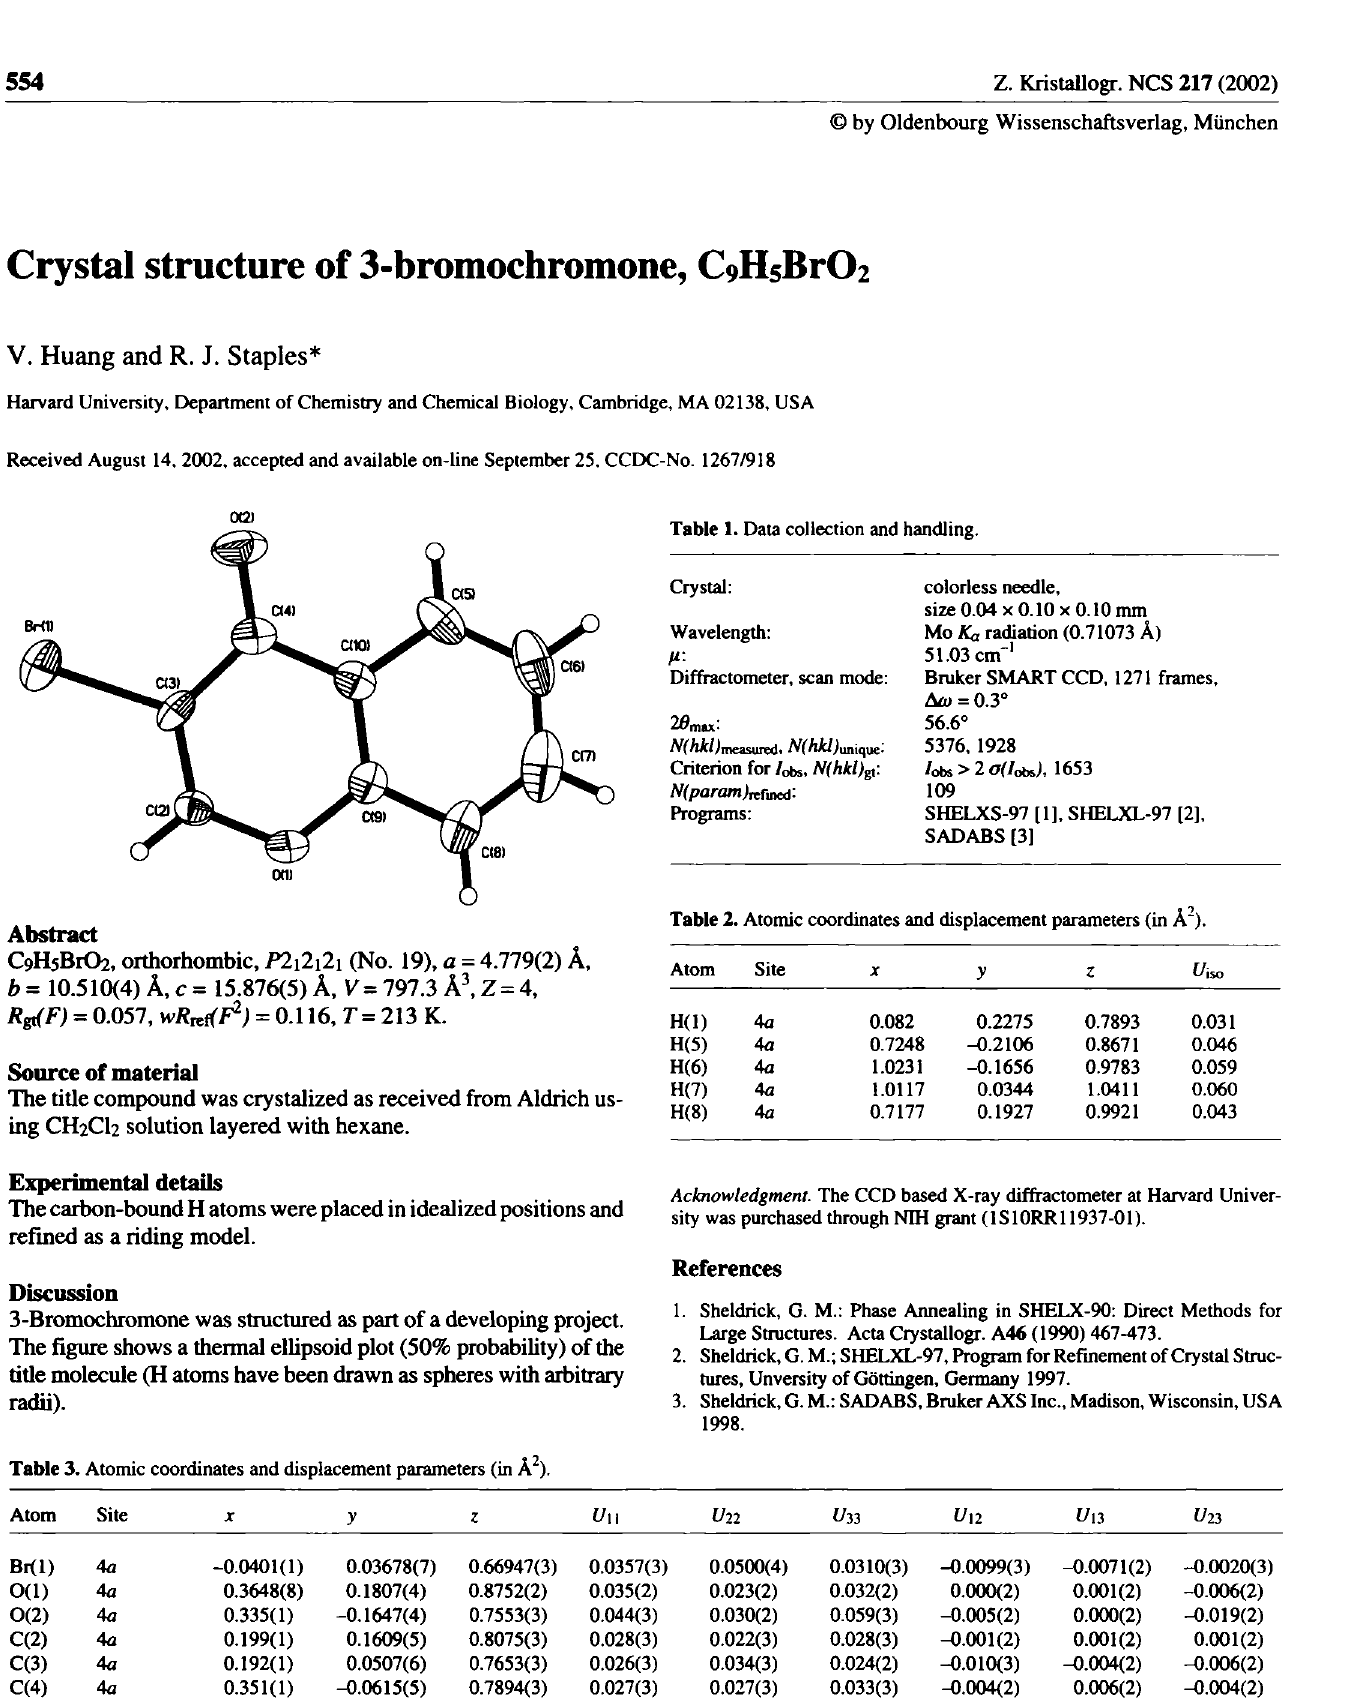
Table 3. Atomic coordinates and displacement parameters (in Â 2